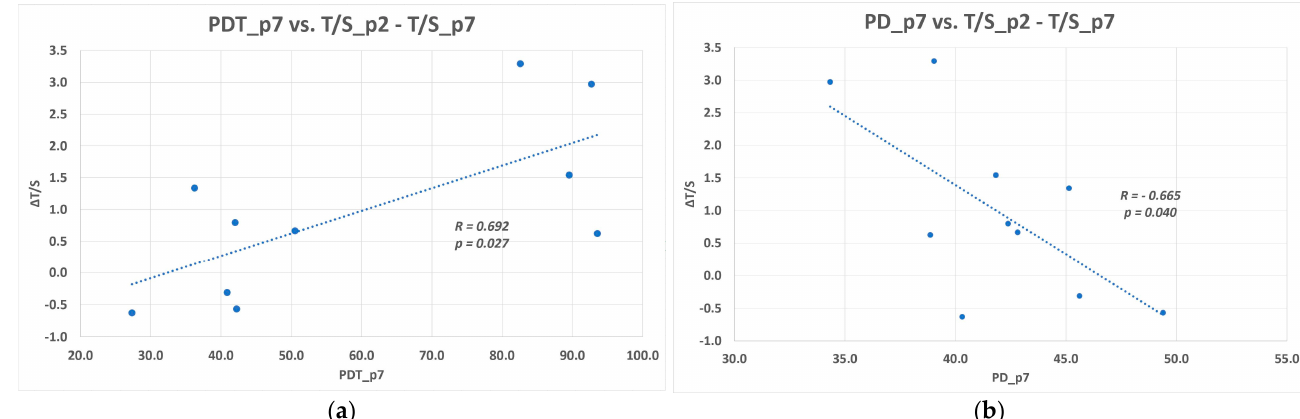
Figure 3. The relationship between the relative telomere length shortening ( ∆ T/S) between p2 and p7 and DPSC kinetics in p7. ( a ) Plot of the ∆ T/S against doubling time (PDT) in the p7, and the regression line; ( b ) Plot of the ∆ T/S against cumulative population doublings (PDT) in the p7, and the regression line. The correlation coefficients of a linear regression fit the shown data the best.